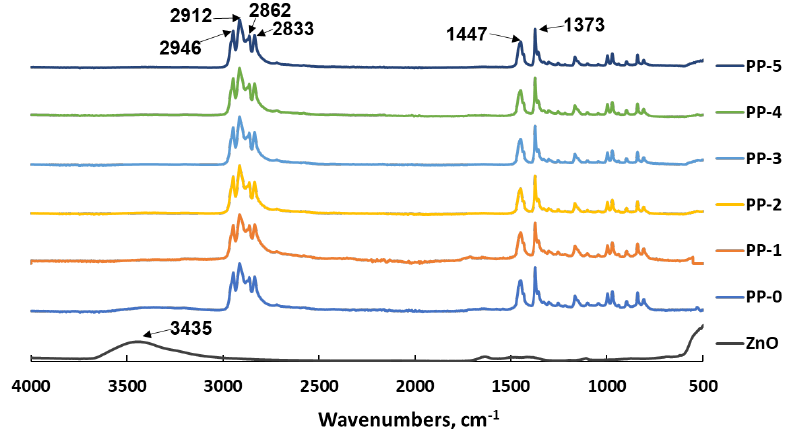
Figure 5. Fourier-transform infrared (FTIR) spectra of ZnO and e-spun PP fibers with different content of ZnO.